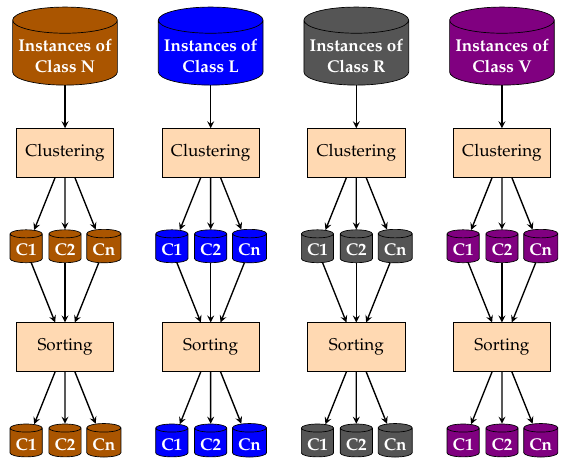
Figure 8. Clustering processes of majority classes.